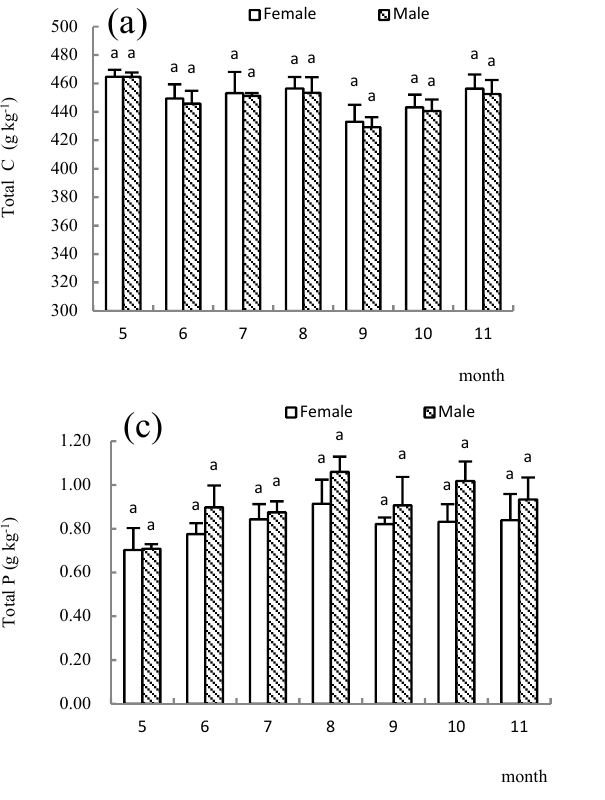
Figure 6. Comparation of C ( a ), N ( b ), P ( c ) content in branch of female and male plants of F. velutina during the growing season. Note: Means not sharing the same letter of female and male plants in the same month indicated significant differences between males and females at an alpha level of 0.05, according to one-way ANOVA.